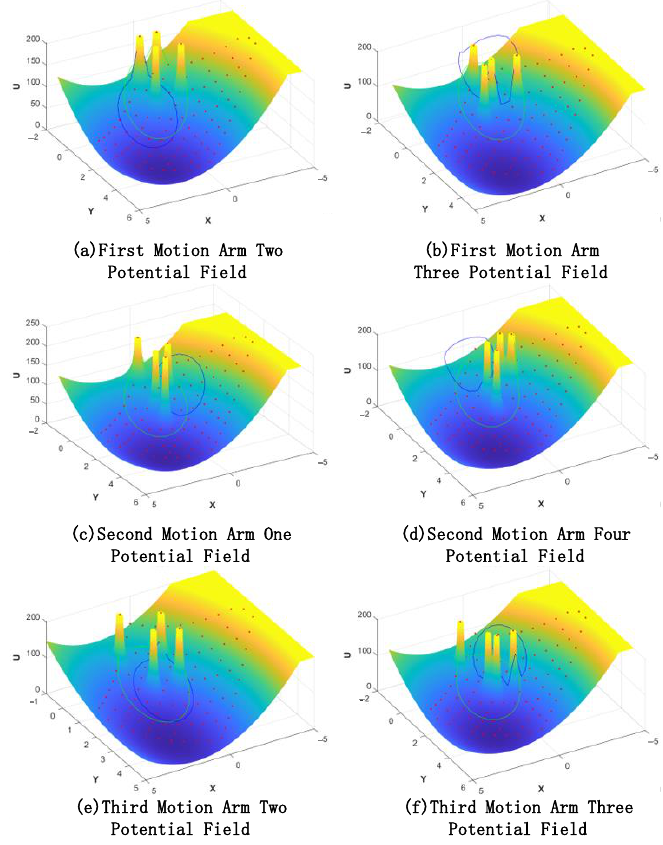
Figure 9. Dynamic potential field diagram with constraints.